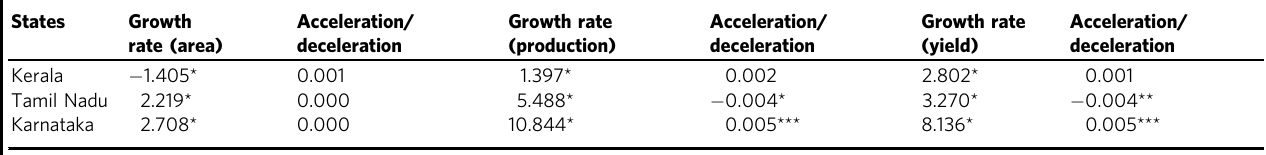
Table 2 Exponential growth and acceleration or deceleration